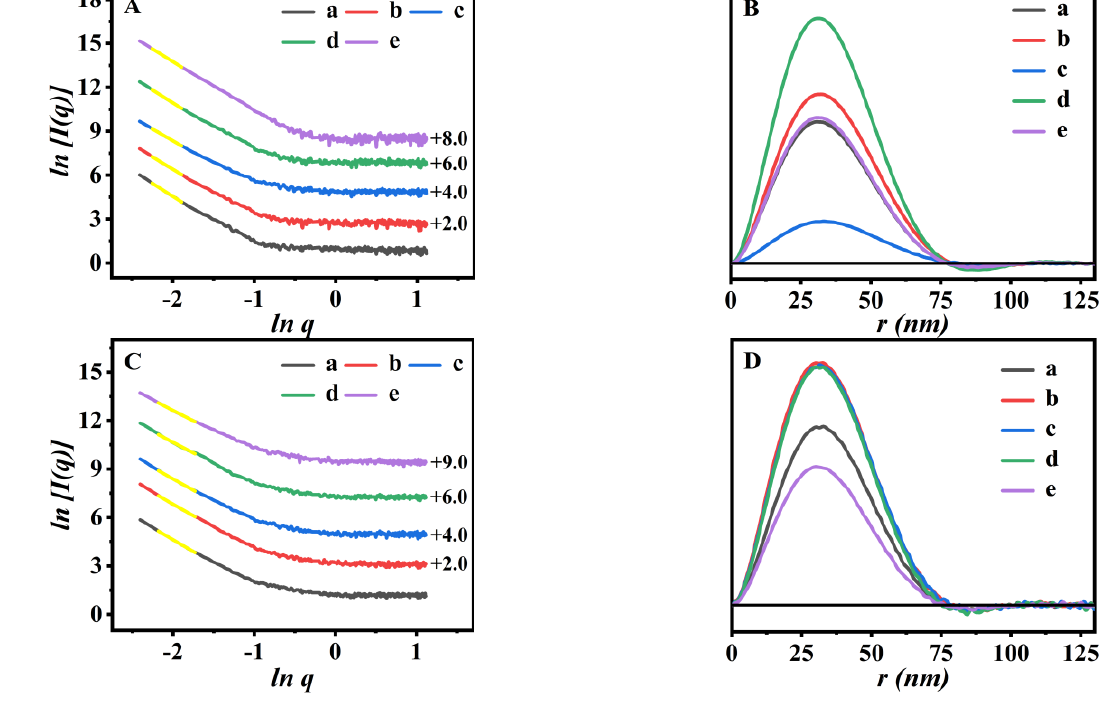
Figure 8. SAXS patterns (yellow lines were fitting curves based on the power low) ( A ) and their PDDF profiles of the drug-loaded samples ( B ). (a) I/P(NA-AA) − 0 − 0.1, (b) I/P(NA-AA) − 0 − 1, (c) I/P(NA-AA) − 0 − 10, (d) I/P(NA-AA) − 1 − 0.1, and (e) I/P(NA-AA) − 7 − 0.1. SAXS patterns (yellow lines are fitting curves) ( C ) of I/P(NA-AA) − 0 − 0.1 in PBS solution (pH 2.0) with drug release time intervals, respectively, and their PDDF profiles ( D ). (a) 1h, (b) 3 h, (c) 5 h, (d) 8 h, and (e) 24 h.